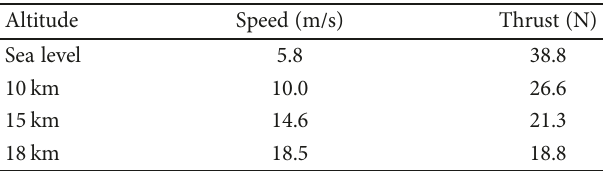
Table 1: Design operating condition and required thrust for each propeller.